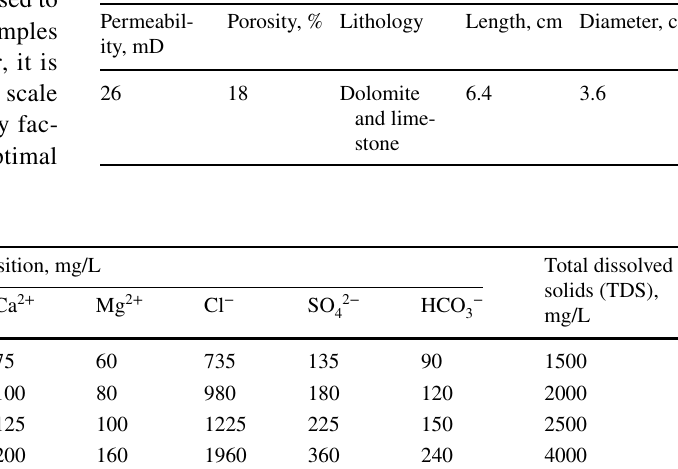
Table 2 Average properties of the used core